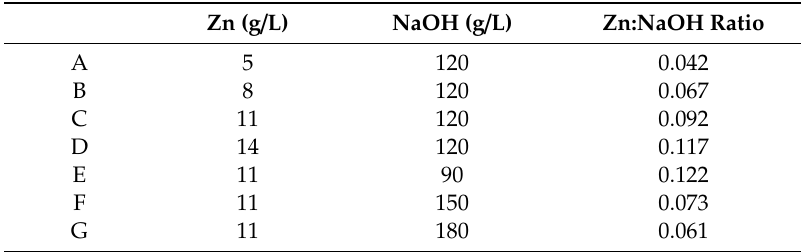
Table 1. Experimental bath